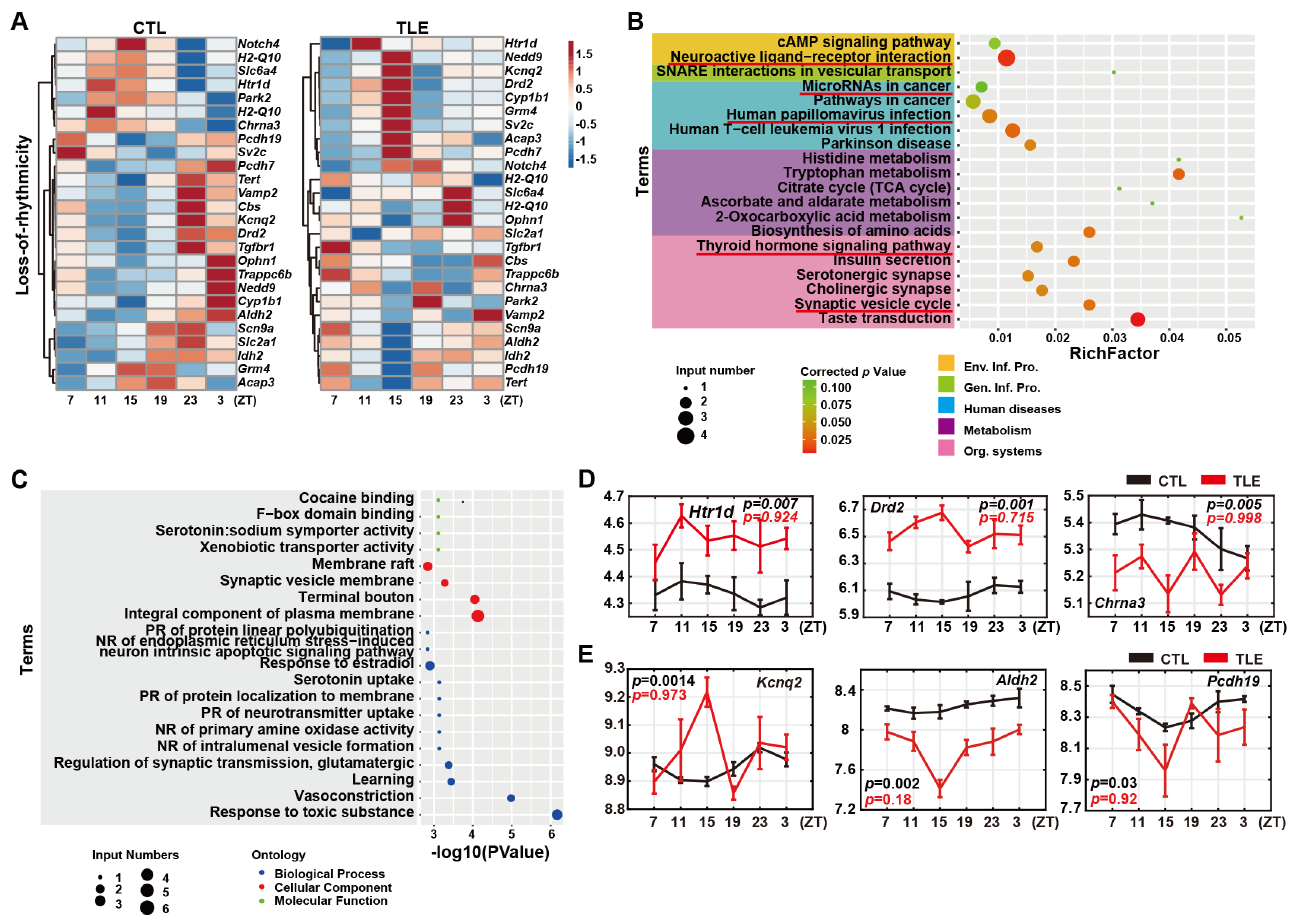
Figure 2. Analysis of 25 loss - of - rhythmicity genes. ( A ) Heatmaps of 25 loss - of - rhythmicity genes in CTL ( left ) and TLE ( right ) mice. ( B ) Top 20 KEGG enrichment pathways of loss - of - rhythmicity genes in TLE mice. Circles represent the gene numbers in specific pathways and colored intensities the corrected P values. The first - level categories of KEGG pathways are marked in different colors. The same pathways that also turn up in KEGG analysis of gain - of - rhythmicity genes are underlined. ( C ) Top 20 GO enrichment terms of loss - of - rhythmicity genes. NR: negative regulation, PR: positive regulation. ( D ) Expression of three representative loss - of - rhythmicity genes Htr1d (5 - hydroxytryp- tamine receptor 1D), Drd2 (dopamine receptor D2), and Chrna3 (cholinergic receptor nicotinic alpha 3 subunit) involved in the neuroactive ligand - receptor interaction pathway. ( E ) Expression of three driver genes in the loss - of - rhythmicity group, including Kcnq2 (Potassium voltage - gated channel subfamily Q member 2) , Pcdh19 (Protocadherin 19), and Aldh2 (Aldehyde dehydrogenase 2 family member). P value of meta2d of each gene was calculated with MetaCycle. The black curve represents gene expression values from the CTL mice, and the red curve is for those in TLE mice. 2.4. Gain-of-Rhythmicity Epileptic Genes in TLE Mice The 34 epileptic genes clearly gain rhythmicity in TLE mice, as shown by the heatmap (Figure 3A) and MetaCycle analysis (Table S3). Intriguingly, KEGG analysis of these 34 gain - of - rhythmicity genes shows the five enriched pathways, such as synaptic vesicle cy- cle and neuroactive ligand - receptor interaction pathways (Figure 3B, Table S10), which also turn up from KEGG analysis of the 25 loss - of - rhythmicity genes (Figure 2B). Hence, in the same pathways, some epileptic genes lose rhythmicity, while the other epileptic genes gain rhythmicity. For instance, in the neuroactive ligand - receptor interaction path- way, some epileptic genes lose rhythmicity (Figure 3B), and the other epileptic genes gain rhythmicity (Figure 2B). In particular, two genes involved in the neuroactive ligand - re- ceptor interaction pathway, P2rx7 (purinergic receptor P2X 7) and Grm1 (glutamate metabotropic receptor 1), gain rhythmicity. P2RX7 transports the calcium into the